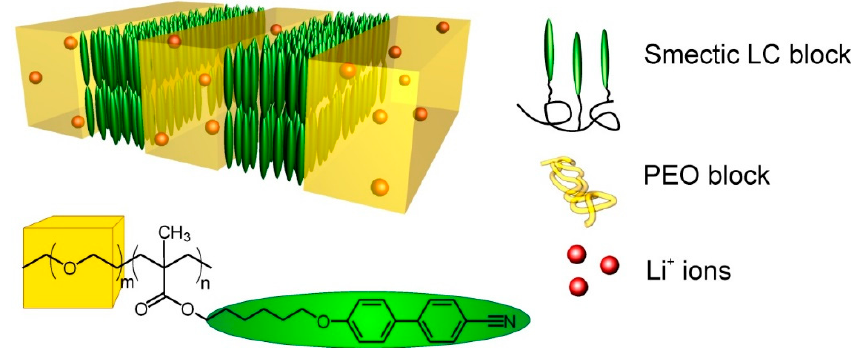
Figure 2. Schematic representation of lithium-doped block copolymer morphology and molecular structure of poly(ethylene oxide-b-6-(4-cyanobiphenyl-4-yloxy)hexylmethacrylate) PEO- b -PMA/CB.